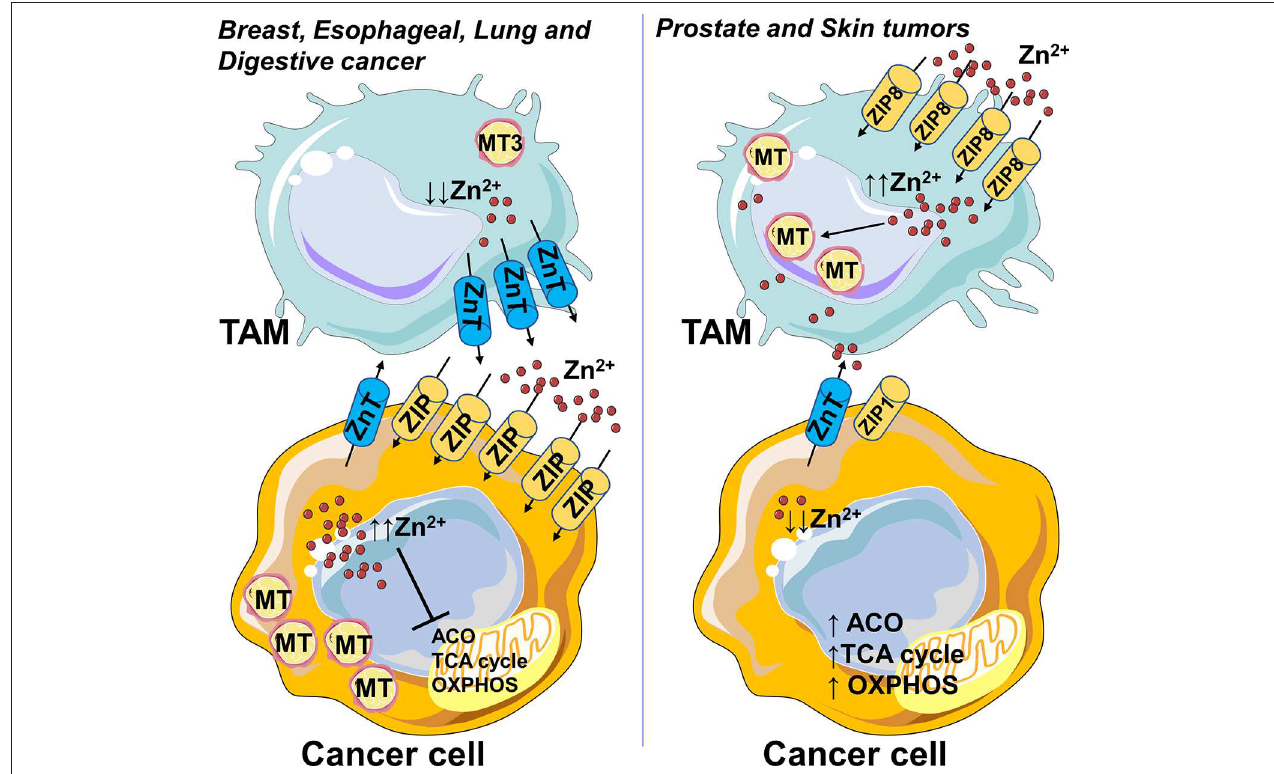
FIGURE 1 | Zinc accumulates in cancer cells or macrophages depending on the type of tumor. Zn accumulation is characteristic of breast, esophageal, lung, and digestive cancer, and correlates with increased expression of cellular Zn importing proteins (ZIP), suggesting that this mechanism allows them to survive. In this context, the M2-like macrophages in the tumor microenvironment could render Zn-pool labile and readily accessible to cancer cells by metallothionein MT3 and ZnT efflux transporters. Unlike other cancer types, prostate and skin tumors have zinc levels lower than normal tissues. Malignant prostate cells lose zinc importer protein ZIP1 and the ability to accumulate zinc, this in turn is associated with a metabolic rewiring, an increased activity of mitochondrial aconitase (ACO) and consequent high citrate oxidation and respiration. In skin tumor, TAMs import zinc and sustain high intracellular levels by upregulation of ZIP8 and metallothioneins, so contributing to protection of cancer cells from Zn toxicity. Higher Zn abduction might be inferred as one of the mechanisms through which TAMs sustain high oxidative metabolism of cancer cells. In parts the figures are based on speculations and have been prepared by assembling in-house built cellular metabolic pathway outlines with a modified and adapted version of BioRender